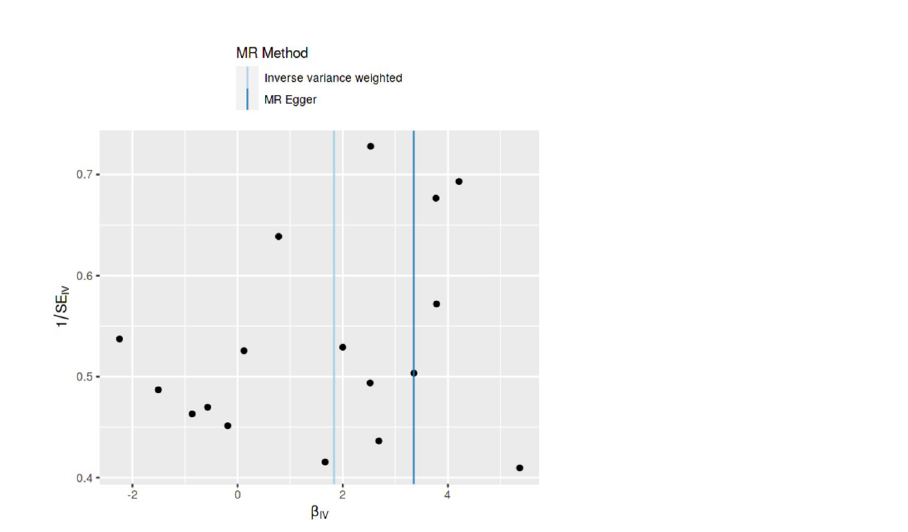
Fig 15. Funnel plot of waist circumference as the exposure, against polycystic ovarian syndrome as the outcome.